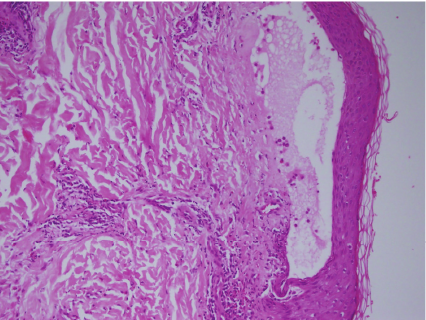
Figure 2: Cutaneous biopsy in lesional skin. The hematoxylin and eosin staining shows dermal-epidermal detachment, with cellular infiltration extending to the dermis (H and E, × 200).